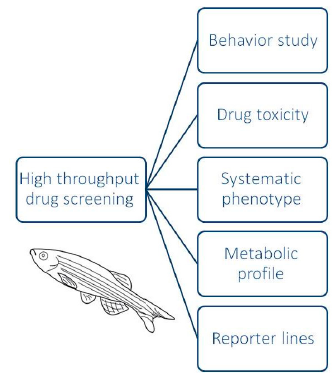
Figure 2. Zebrafish model for high-throughput drug screening. Zebrafish is a valuable tool for high-throughput screening assays. In terms of toxicity, zebrafish have been used to evaluate a specific organ or behavior with respect to toxicity. In drug screening, zebrafish is also established as precious platform to multiple systemic phenotype studies simultaneously with metabolic profiles and toxicity reporter lines.